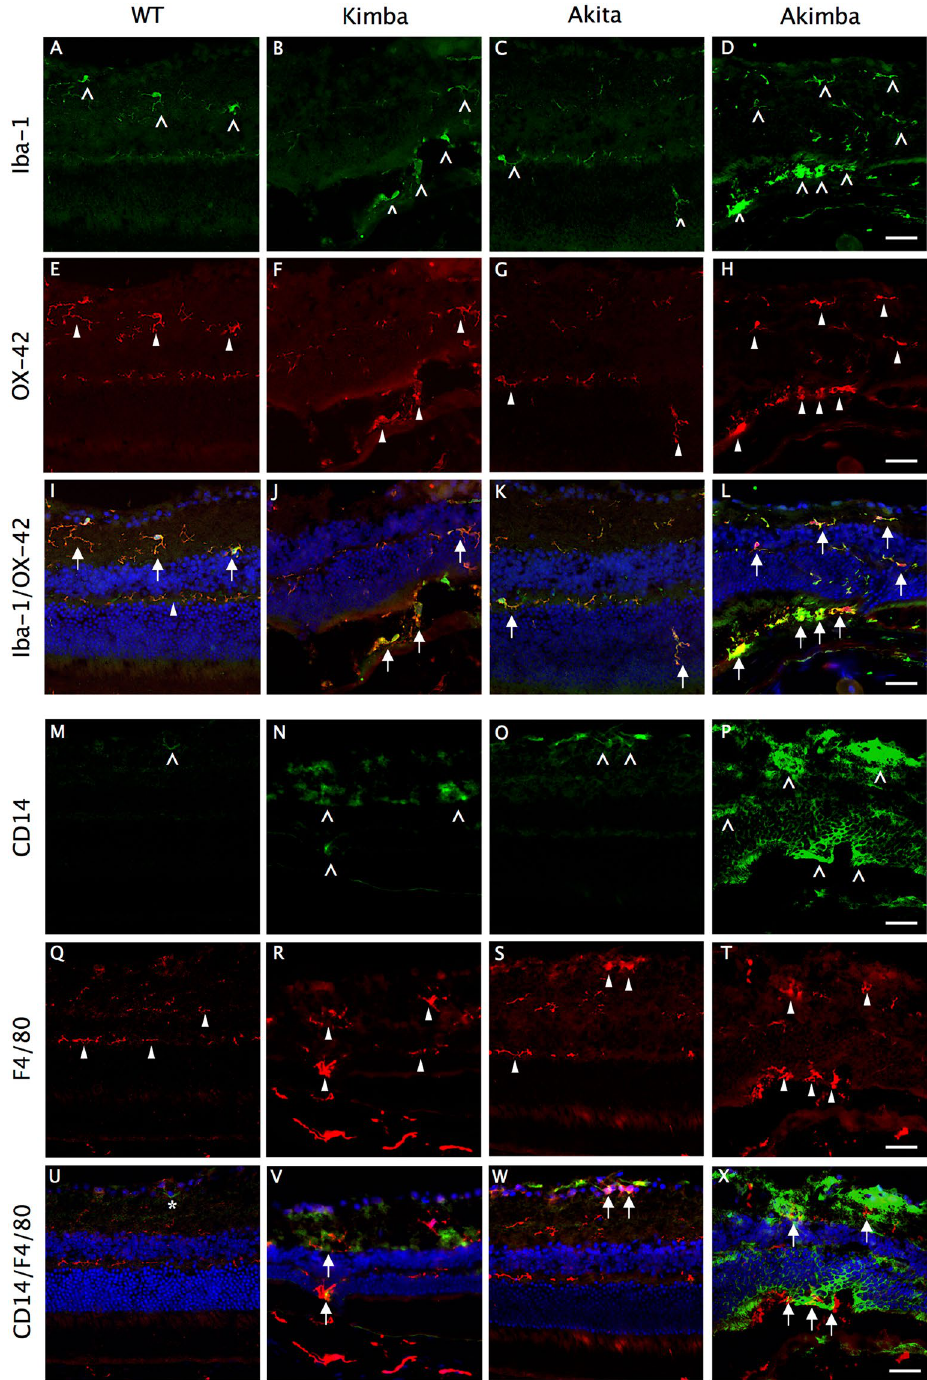
Figure 4. Elevated expression of macrophage/microglia markers in Akimba mouse. Double immunostaining of Iba-1 ( A – D ) with OX-42 ( E–H ), and CD14 ( M – P ) with F4/80 ( Q – T ). Iba-1 staining (arrowheads) in WT ( A ) mice showed resident microglial cells with normal ramified morphology in the inner retina. Akita ( C ) mice showed minimal activation of microglia, however, had displaced microglia in the outer nuclear layer (ONL). Iba-1 + cells were both increased and amoeboid shaped in the outer retina of Kimba ( B ), and maximal activation was seen in Akimba ( D ) retina. OX-42 (block arrowheads) stains a cell surface antigen expressed by microglia, hence co-localized (arrows) with Iba-1 + microglia in WT ( I ). Majority of Iba-1 + microglia in Kimba ( J ), Akita ( K ) and Akimba ( L ) mice retina also stained positive for OX-42 (arrows). CD14 (arrowheads) is expressed by perivascular macrophages, which were minimal and located only around the vessels in the ganglion cell layer of the WT ( M ) mice. Increased expression was seen in the Kimba ( N ) and Akita ( O ) mice, and was drastically elevated in the outer retina of Akimba ( P ) mice, indicating migratory perivascular cells around new vessel sprouting from choroid into photoreceptor (PhR) region. F4/80 (block arrowheads)